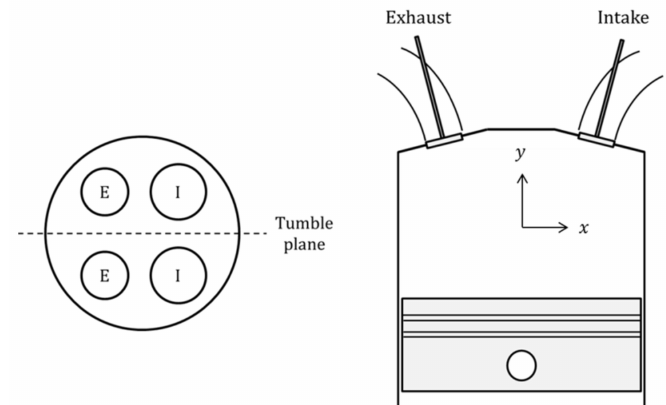
Figure 1. Model engine characteristics. The VVT offset adjustment was made with the grey part in Figure 2. This part locked the camshaft before installing the timing belt and the angle of its rectangular openwork set the VVT offset. As the camshaft made one rotation for two rotations of the crankshaft, the angle of the rectangular openwork was half the VVT offset in crank angle degrees.